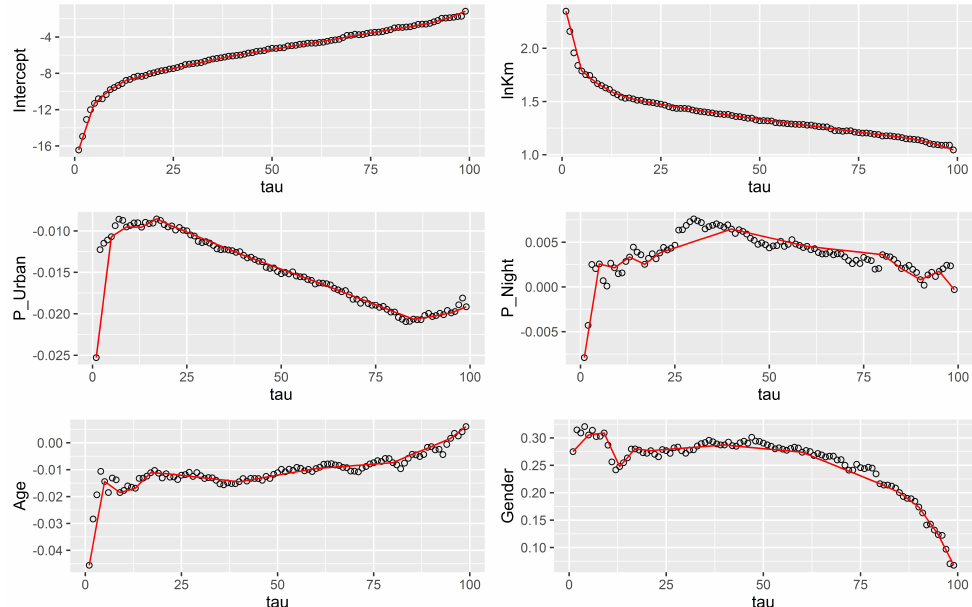
Figure 5. Estimates of β τ for different quantile levels. Dots indicate the parameter estimates when adjusting 99 quantile regressions, lines denote the approximations obtained for m = 13 initial quantile regressions with a suitable choice of τ